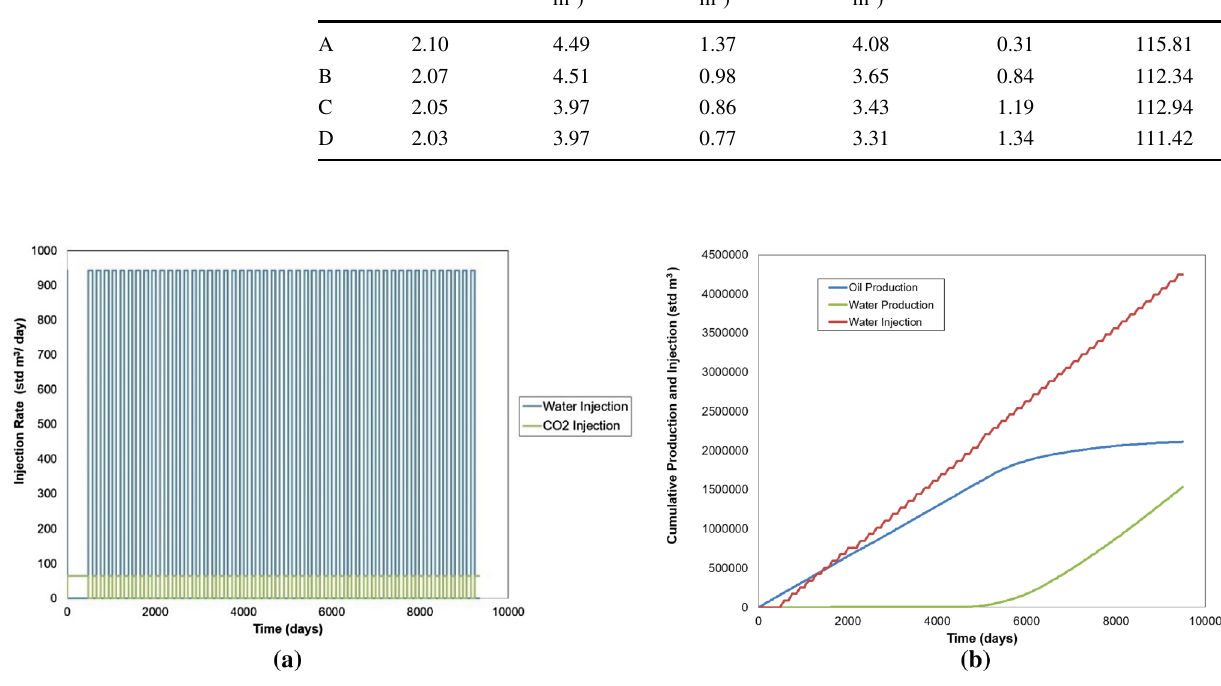
Fig. 4 Graphs of ( a ) water and CO 2 injection rate curves and ( b ) cumulative productions and water injection for WAG recovery in case